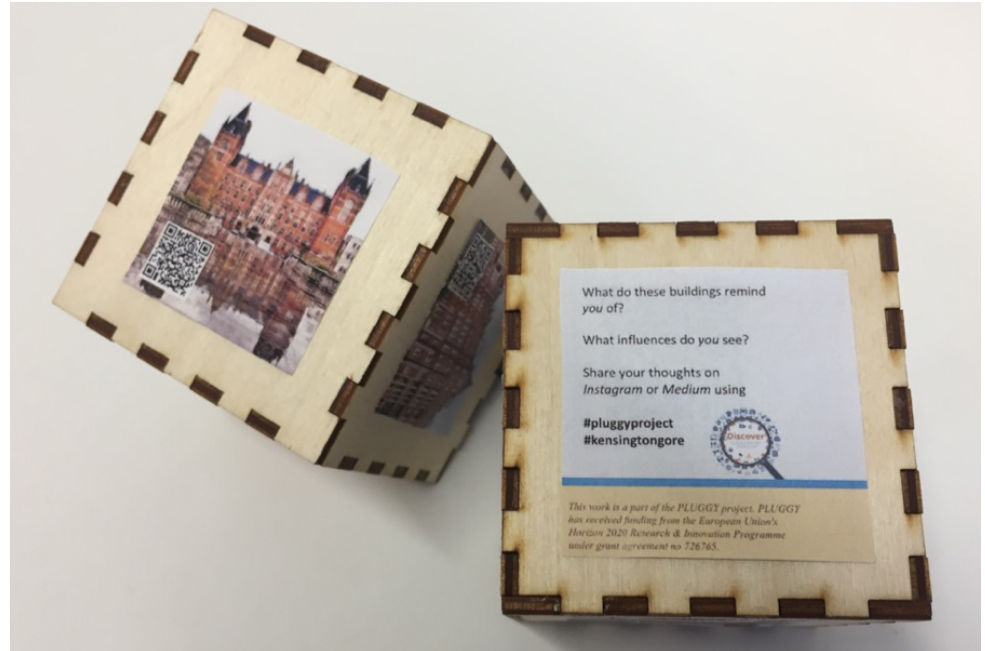
Figure 2. Each participant used a cube with images and QR codes on the various sides to access the text and audio information for each target. On one side of the cube, questions were shown to trigger visitors thoughts when roaming